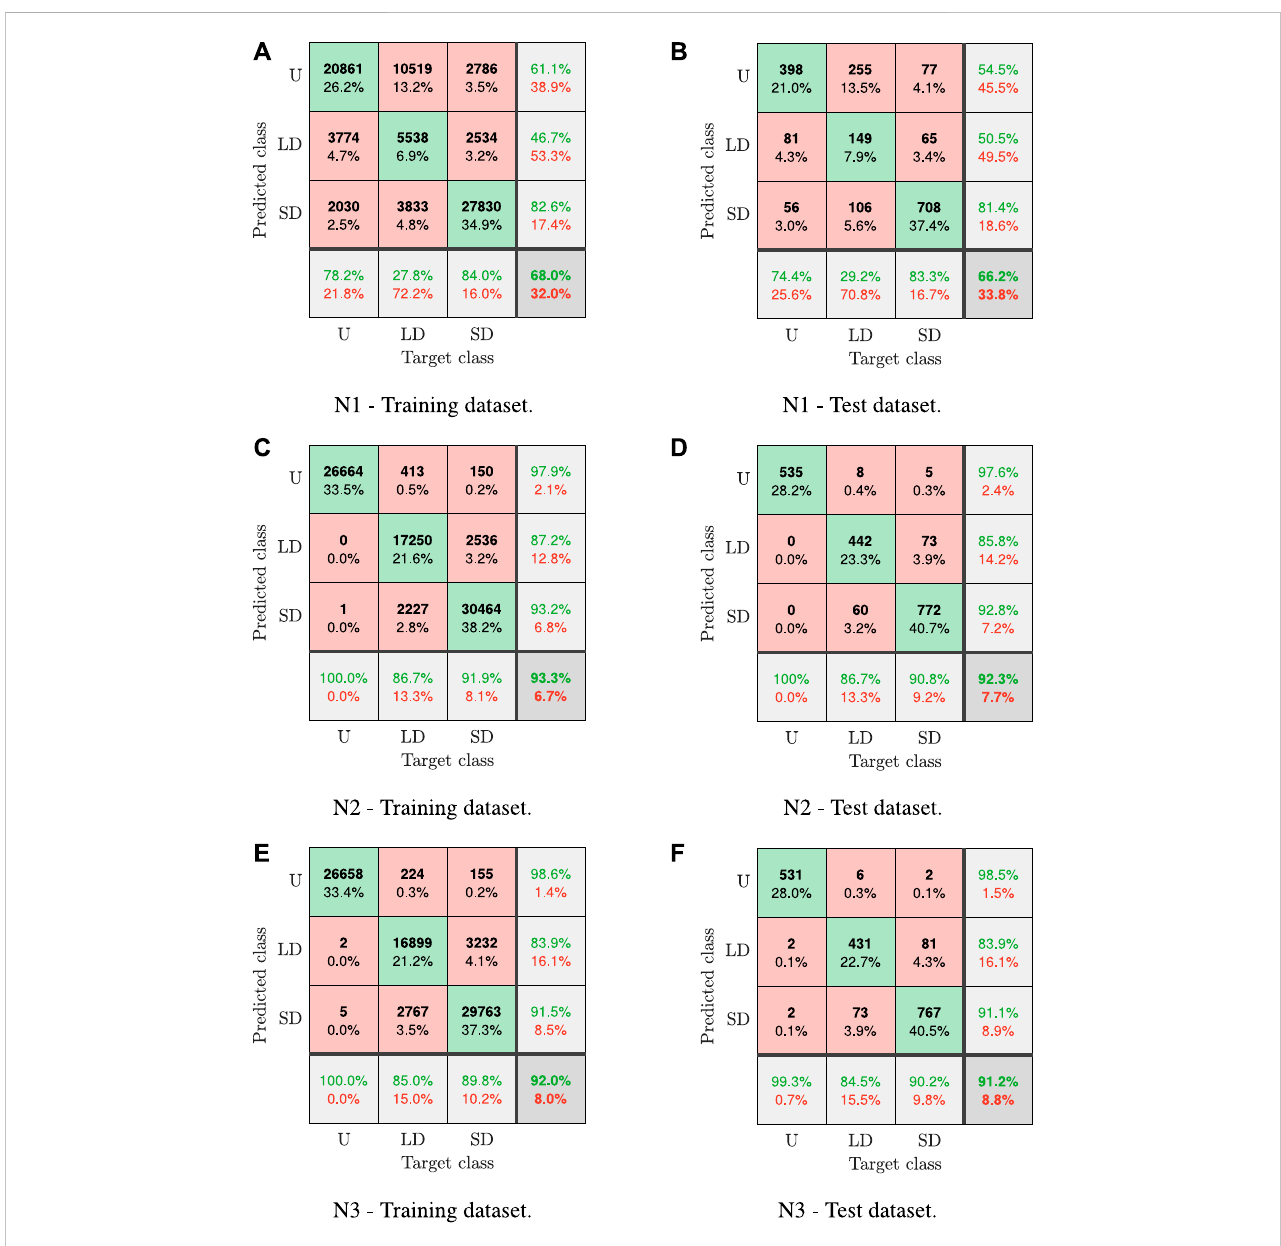
FIGURE 6 Numerical case study: confusion matricies of the trained fi nal networks N1, N2, and N3 computed for (A,C,E) the training dataset and (B,D,F) the test dataset. U, undamaged; LD, light damage; SD, severe damage.